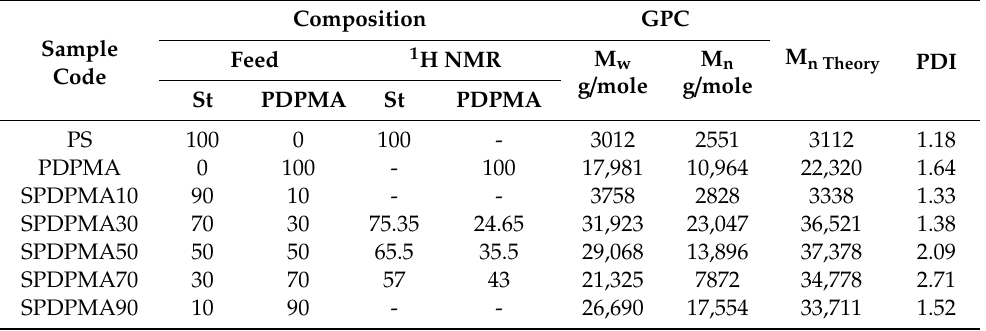
Table 1. Composition and characteristics of styrene (St)-PDPMA copolymers synthesized via ATRP. Sample Code